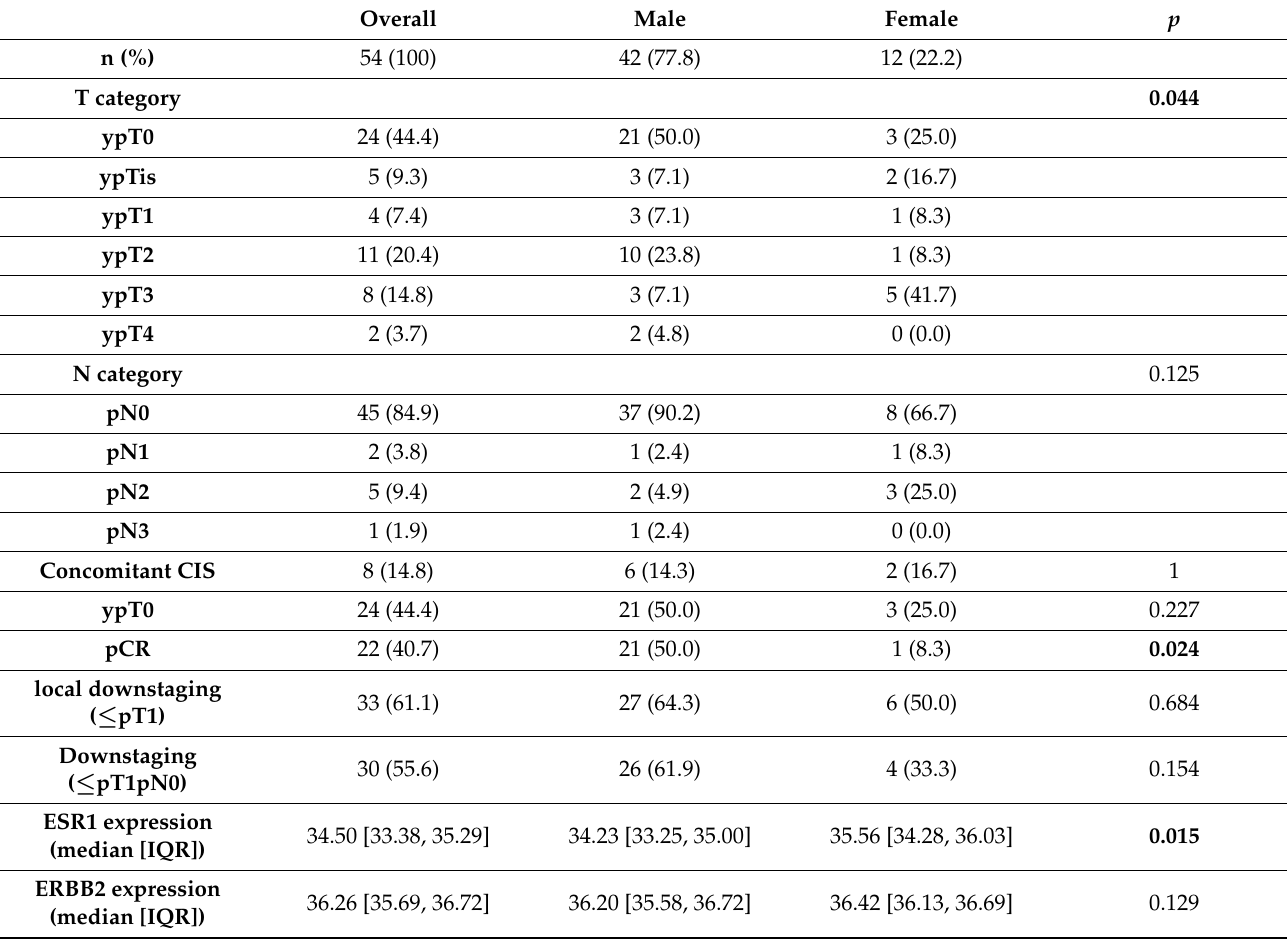
Table 2. Treatment characteristics according to gender at radical cystectomy ( n = 54).